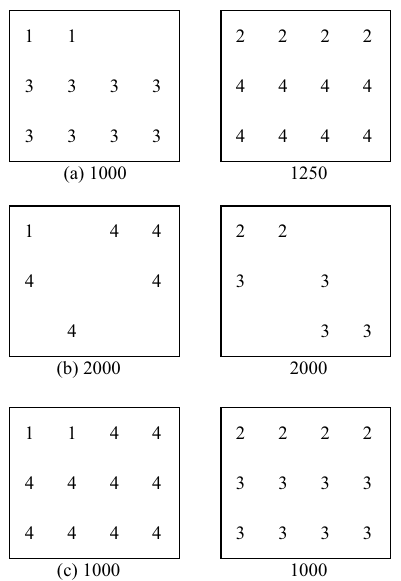
Fig. 1. Three various allocations of templates for Example 1 number of prints is 2250 (=1000+1250), the allocation of templates in Fig. 1(b) requires 2 templates and the total number of prints is 4000 (=2000+2000), and the allocation of templates in Fig. 1(c) requires 2 templates and the total number of prints is 2000